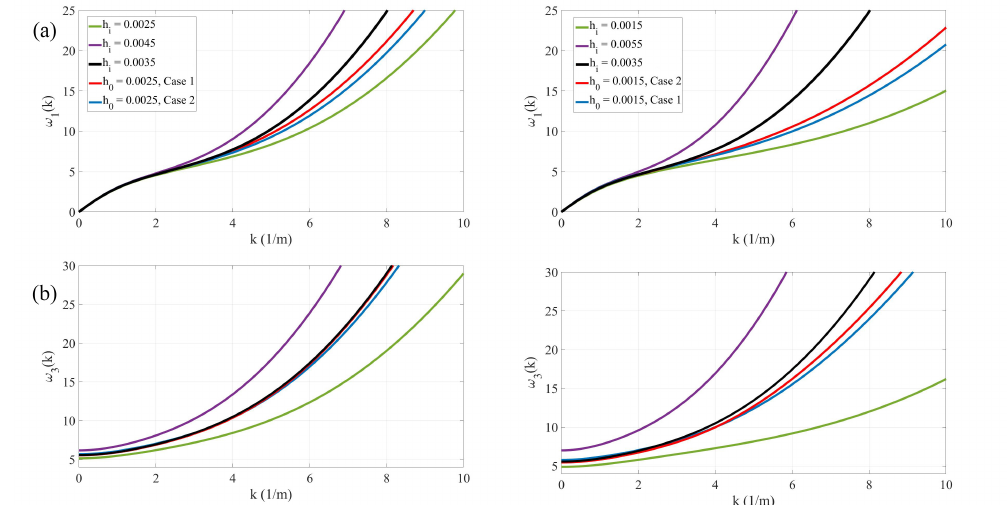
Figure 5. Dispersion relations of the first ( a ) and third ( b ) modes for h 0 = 0.0025 m ( left ) and for h 0 = 0.0015 m ( right ) for non-uniform plate and for uniform plate with h i equal to values of h 0 , h ∗ and h 1 of the ice thickness of non-uniform plate (these values are shown in the legend). Red lines show the results for Case 1, blue—for Case 2. Black line shows the results for a plate with constant thickness equal to h ∗ = 0.0035 m. Purple and green lines show the results for a plate with constant thickness equal to h 1 and h 0 , respectively.